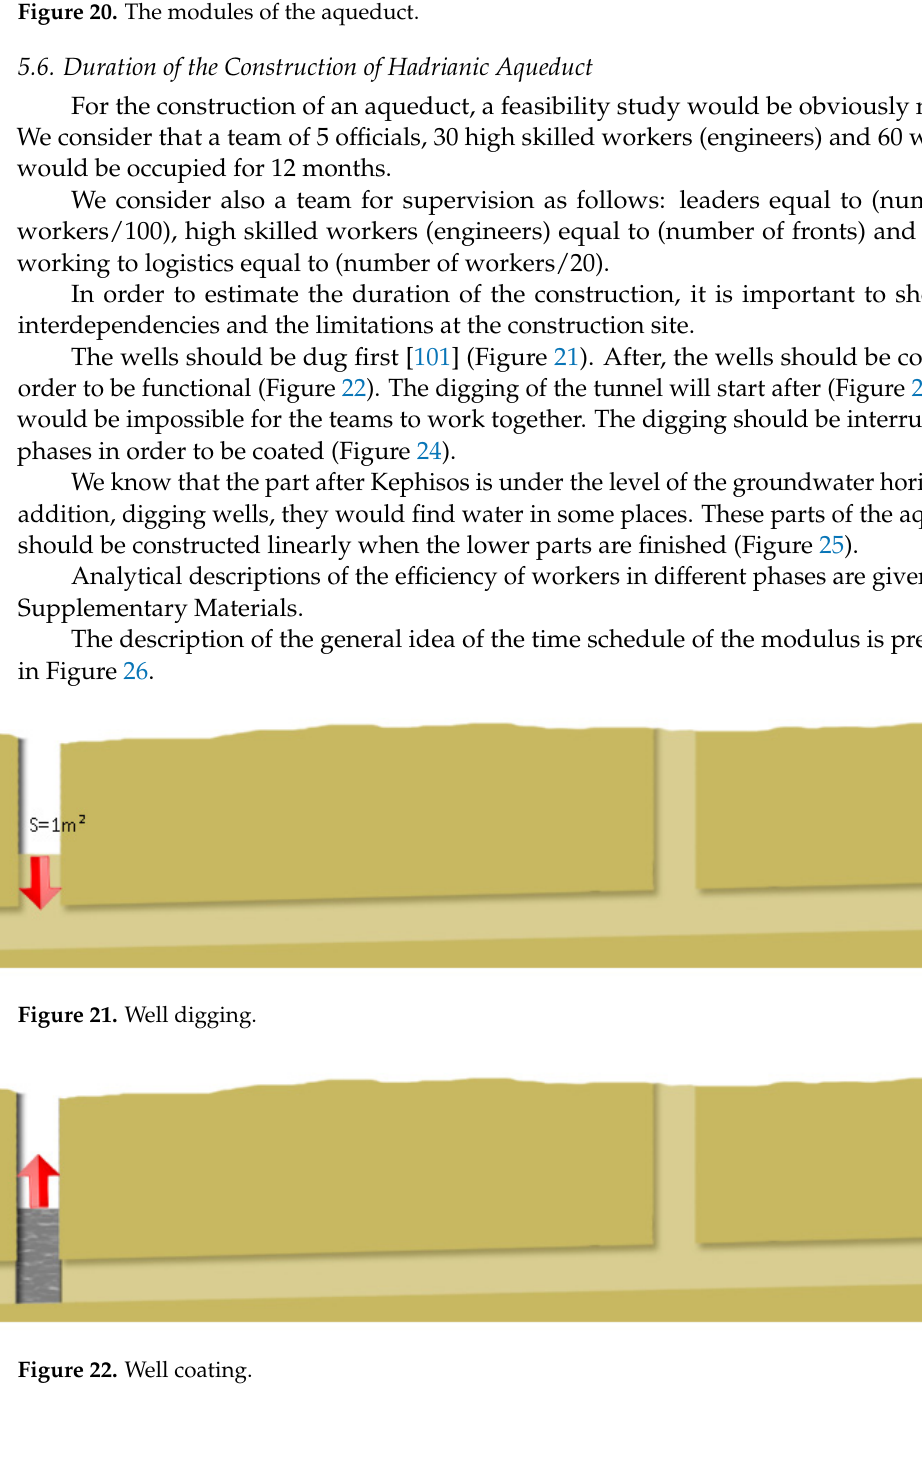
Figure 20. The modules of the aqueduct.